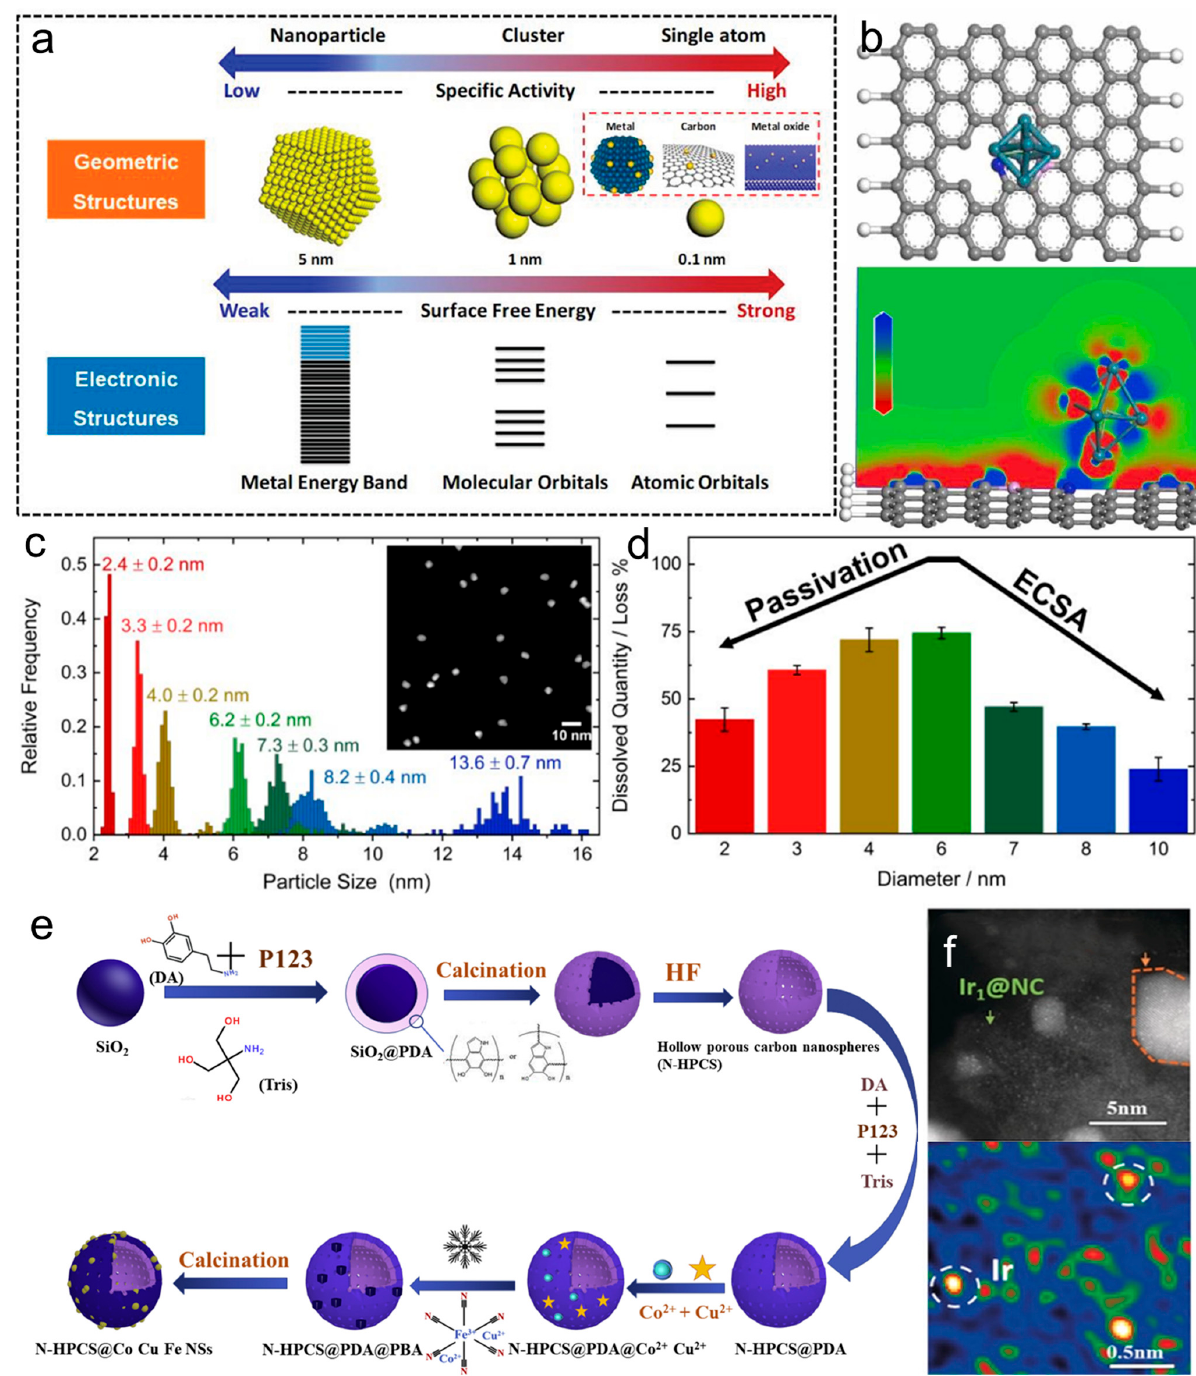
Figure 7. ( a ) Geometric and electronic structures of single atom, cluster, and nanoparticle. Reproduced with permission of [57], copyright 2022 John Wiley and Son. ( b ) Atomic structures of Ru/d-NPC and electron localization function of Ru/d–NPC. Reproduced with permission of [61], copyright 2022 Elsevier. ( c ) Pt particles with diameters of 2 to 10 nm and ( d ) the oxophilicity and electrochemically active surface area influenced by particle size. Reproduced with the permission of [62], copyright 2020 ACS Publishers. ( e ) Schematic illustration for the synthesis of Co, Cu, Fe alloy nanospheres with diameter of 200 nm. Reproduced with permission of [63], copyright 2022 Elsevier. ( f ) HAADF–STEM image of Ir 1 @Co/NC at high magnification and FFTI–HAADF image of Ir 1 @NC area. Reproduced with permission of [64], copyright 2019 John Wiley and